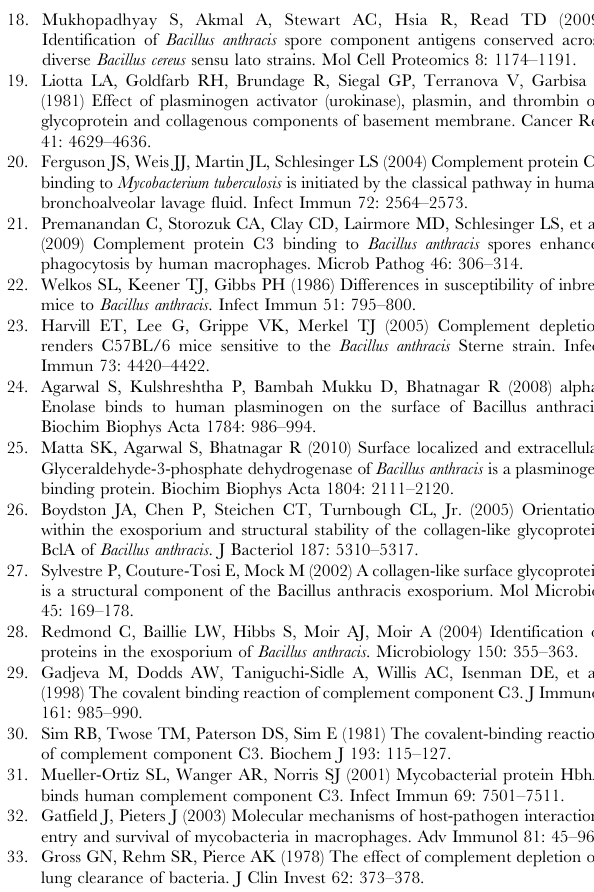
Table S2 Identification of human serum proteins interacting with B. anthracis spores. Spore-bound serum proteins were subjected to LTQ-MS/MS. Percentage of wrong identification was estimated to be , 2%, and # IDs $ 5 are listed. # Peptides and # IDs represent the number of different peptides detected from this protein and the total number of peptide identifications from this protein,